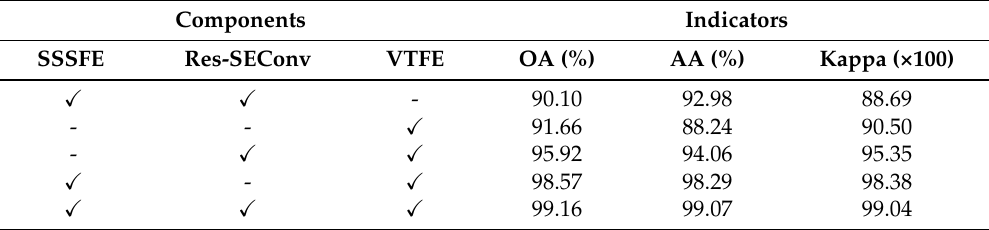
Table 9. The classification results of ablation experiments on the IP dataset.